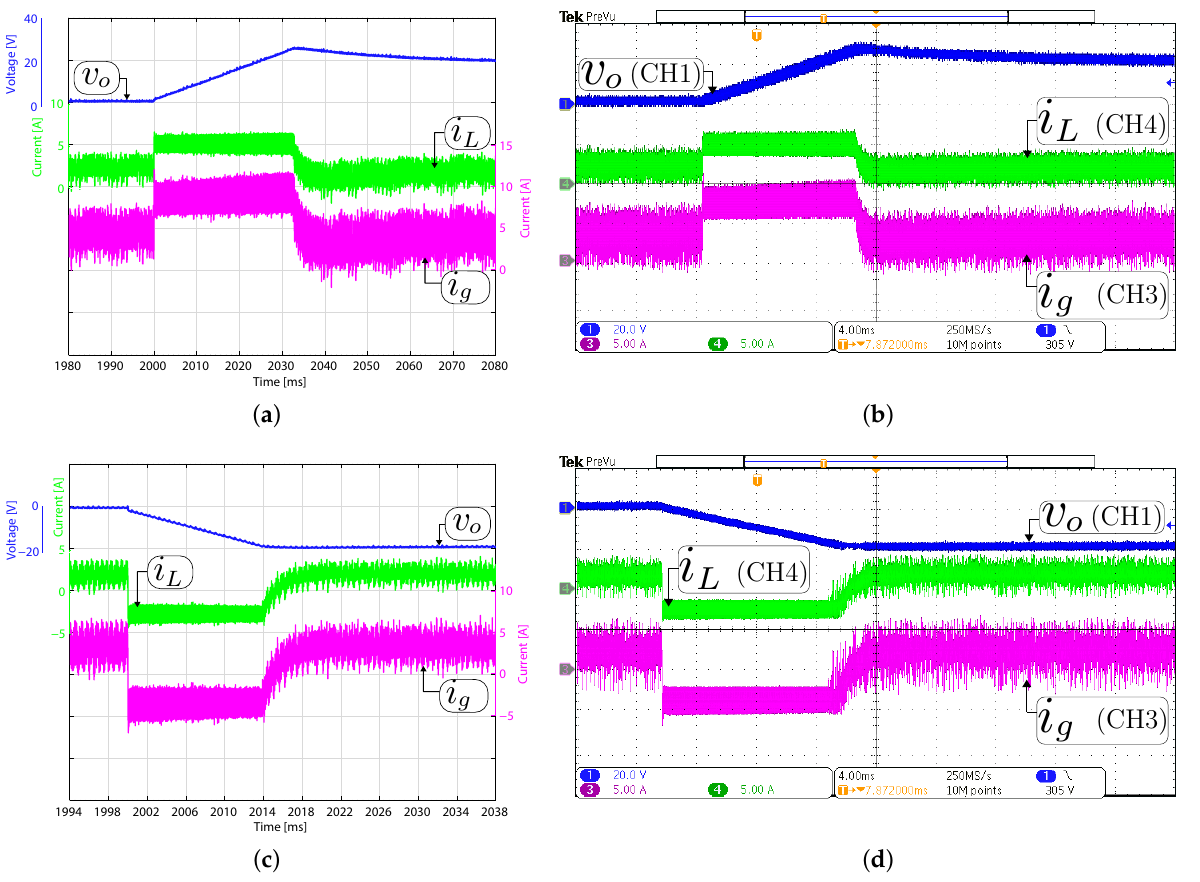
Figure 15. Boost operation mode in steady-state with an EV powertrain system emulation V g = 200 V. Transient response when the output voltage reference changes from 300 to 320 V. Simulated ( a , c ) and experimental ( b , d ), time base of 10ms ( a , b ), and from 320 to 300 V, time base of 4ms ( c , d ). CH1: V o (20 V/div), CH3: i g (5 A/div), CH4: i L (5